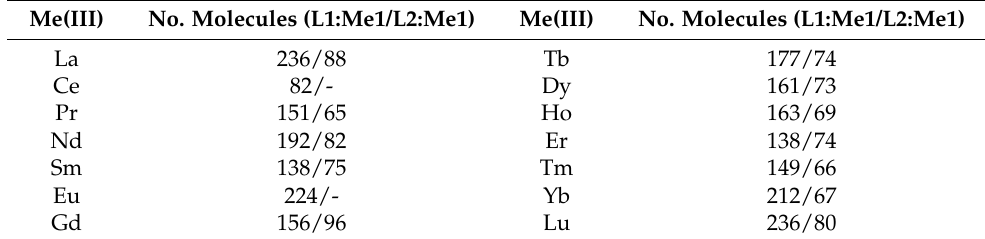
Table 1. Amounts of molecules in the collected datasets.